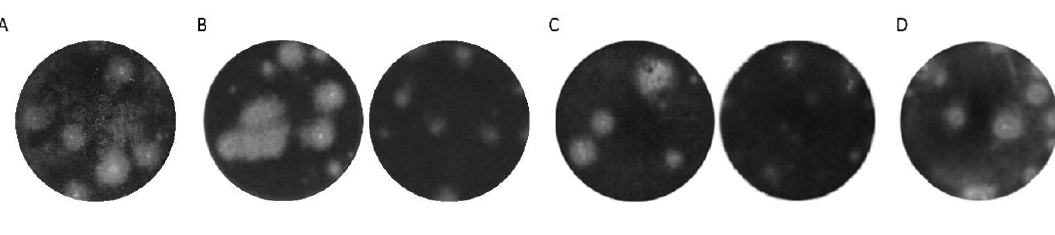
Figure 1. Viral replication kinetics during serial passages of tick-borne encephalitis virus parental strain Hypr in mammalian porcine kidney cells (PS) (dark line with triangles) and in the tick cell line IRE/CTVM19 (light line with circles). The titer was determined using plaque assay and viruses were sampled once at the indicated passage levels per virus variant.